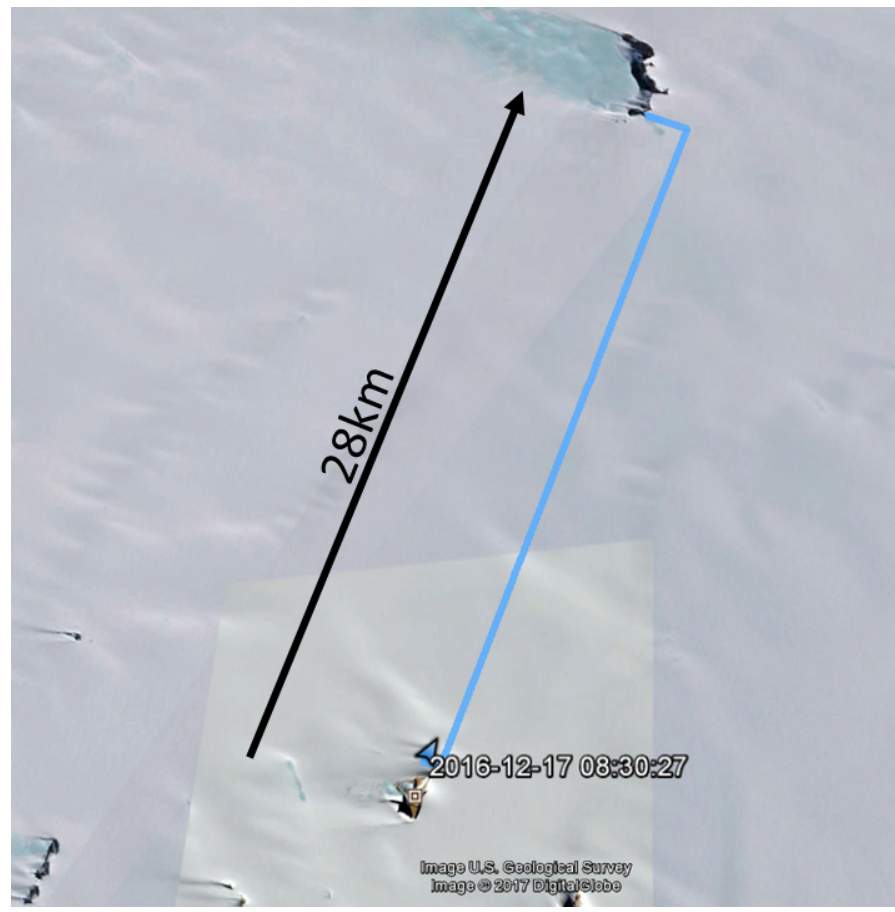
Figure 8. Route from the station Princess Elisabeth Antarctica (PEA) to Vesthaughen followed during the